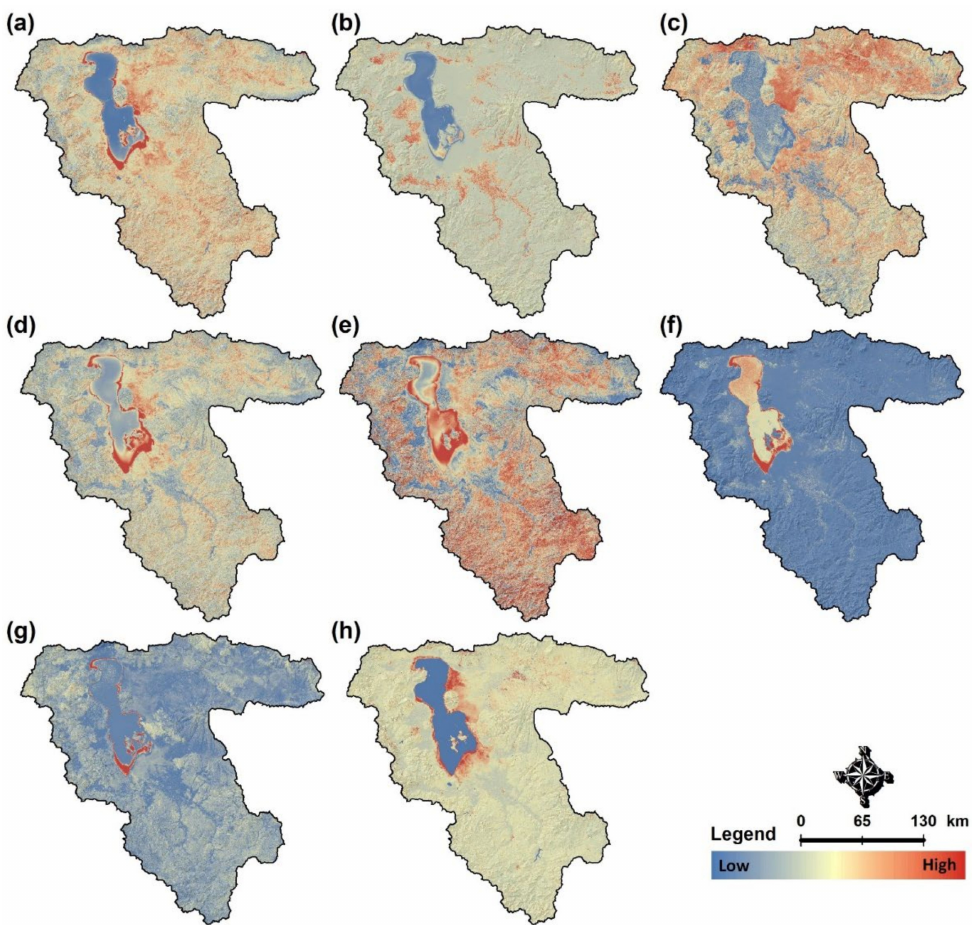
Figure 6. The soil salinity monitoring indices applied to the satellite images of 2020 using the different soil salinity indexes of ( a ) CSRI, ( b ) NDSI, ( c ) VSSI, ( d ) SI-T, ( e ) SI-1, ( f ) SI-2, ( g ) SI-3, and ( h ) NDII, whereby red indicates areas with high soil salinity. Due to the large number of maps generated in this research, we only show the results of soil salinity indices for